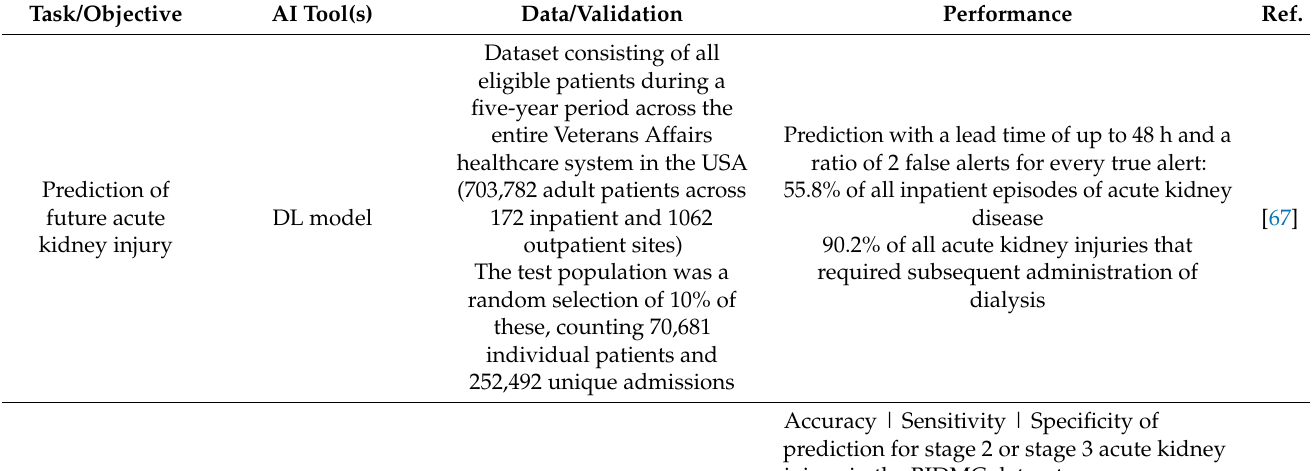
Table 6. Summary of the recent AI studies in